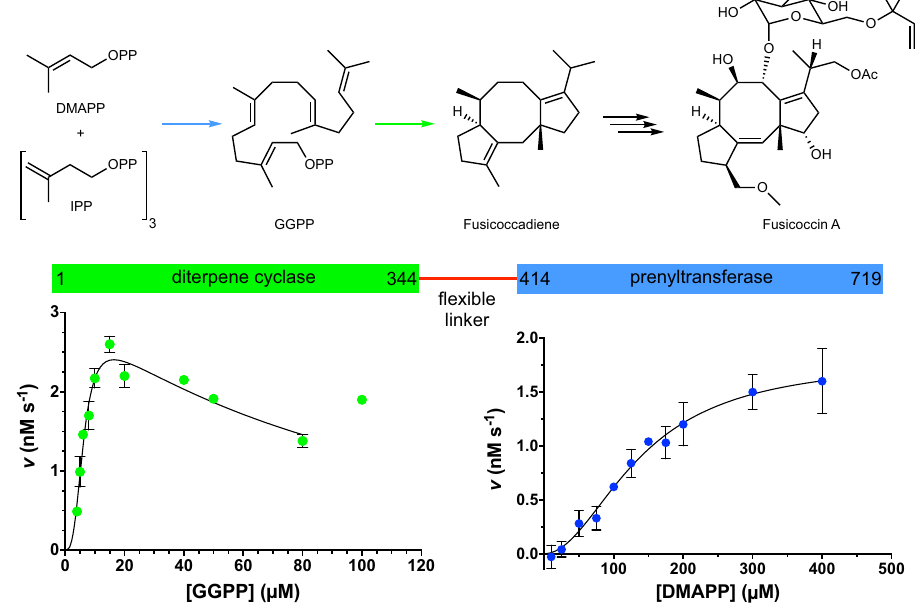
Fig. 1 Mechanism and catalytic activity of fusicoccadiene synthase (PaFS). Prenyltransferase and diterpene cyclization reactions in the fi rst steps of Fusicoccin A biosynthesis catalyzed by PaFS, a bifunctional assembly-line terpenoid synthase ( OPP diphosphate, DMAPP dimethylallyl diphosphate, IPP isopentenyl diphosphate, GGPP geranylgeranyl diphosphate). Reaction arrow colors correspond to catalytic domain colors in the simpli fi ed representation of primary structure (blue for prenyltransferase and green for cyclase); catalytic domains are indicated by fi rst and last residue numbers. Reaction kinetics (enzyme velocity, v ) for each catalytic domain are also shown. The prenyltransferase reaction with DMAPP and IPP (blue data points) exhibits sigmoidal dependence on DMAPP concentrations with excellent curve fi t ( R 2 = 0.95) and steady-state parameters k cat = 1.01 ± 0.09 × 10 − 3 s − 1 , K M = 139 ± 16 µ M, k cat / K M = 7.3 ± 1.5 M − 1 s − 1 , and Hill coef fi cient n = 2.0 ± 0.3. Each data point represents the mean ±standard deviation ( n = 3). The GGPP cyclization reaction (green data points) exhibits sigmoidal dependence on GGPP concentration as well as substrate inhibition. Taking cooperativity as well as substrate inhibition into account, data with [GGPP] ≤ 80 µ M were fi t to Eq. 1 (Methods), yielding an excellent curve fi t ( R 2 = 0.93) and steady-state